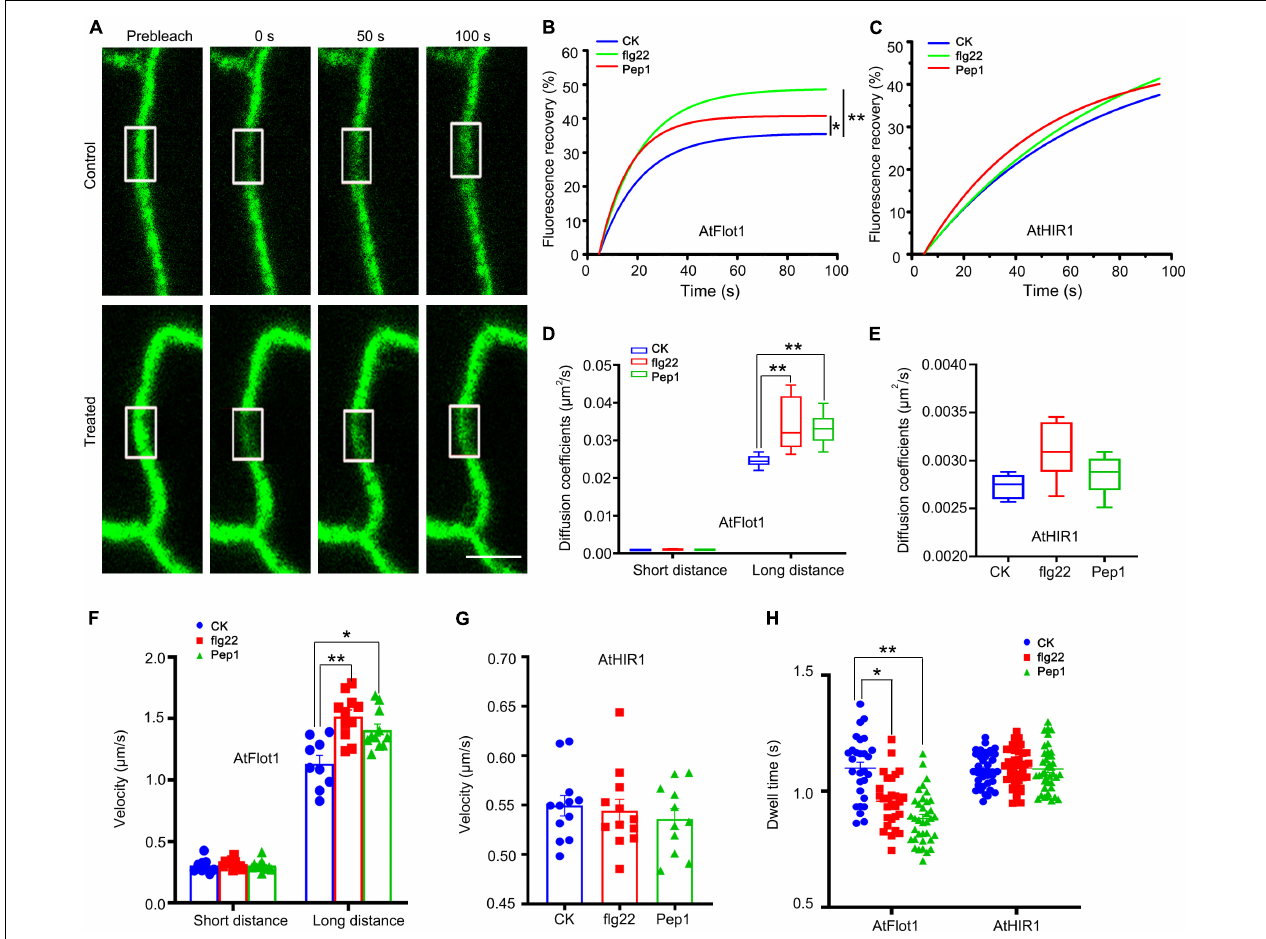
FIGURE 6 | Dynamics of GFP-AtFlot1 and AtHIR1-GFP at the PM under control and flg22 and Pep1 treatment conditions. (A) FRAP time course of cells expressing GFP-AtFlot1. White squares indicate bleached regions. Bar = 5 µ m. (B) Fluorescence recovery curves of the photobleached region of interest in GFP-AtFlot1-expressing cells under control and flg22 and Pep1 treatment conditions. For each examination, at least 15 cells from each of five seedlings were examined. In each case, three biological replicates were performed. Statistical significance was determined using Student’s t -tests (* P < 0.05; ** P < 0.01). (C) Fluorescence recovery curves of the photobleached region of interest in AtHIR1-GFP-expressing cells under control and flg22 and Pep1 treatment conditions. For each examination, at least 15 cells from each of five seedlings were examined. In each case, three biological replicates were performed. Statistical significance was determined using Student’s t -tests. (D) Long-distance and short-distance diffusion coefficients for GFP-AtFlot1 in different environments. For each examination, at least 30 cells from each of five seedlings were examined. In each case, three biological replicates were performed. Statistical significance was determined using Student’s t -tests (** P < 0.01). (E) Diffusion coefficients of AtHIR1-GFP under different conditions. For each examination, at least 30 cells from each of five seedlings were examined. In each case, three biological replicates were performed. Statistical significance was determined using Student’s t -tests. (F) The velocity of GFP-AtFlot1 under different conditions. For each examination, at least 15 cells from each of five seedlings were examined. In each case, three biological replicates were performed. Statistical significance was determined using Student’s t -tests (* P < 0.05; ** P < 0.01). (G) The velocity of AtHIR1-GFP under different conditions. For each examination, at least 15 cells from each of five seedlings were examined. In each case, three biological replicates were performed. Statistical significance was determined using Student’s t -tests. (H) Dwell times of GFP-AtFlot1 and AtHIR-GFP under control and flg22 and Pep1 treatment conditions. For each examination, at least 20 cells from each of five seedlings were examined. In each case, three biological replicates were performed. Statistical significance was determined using Student’s t -tests (* P < 0.05; ** P < 0.01).